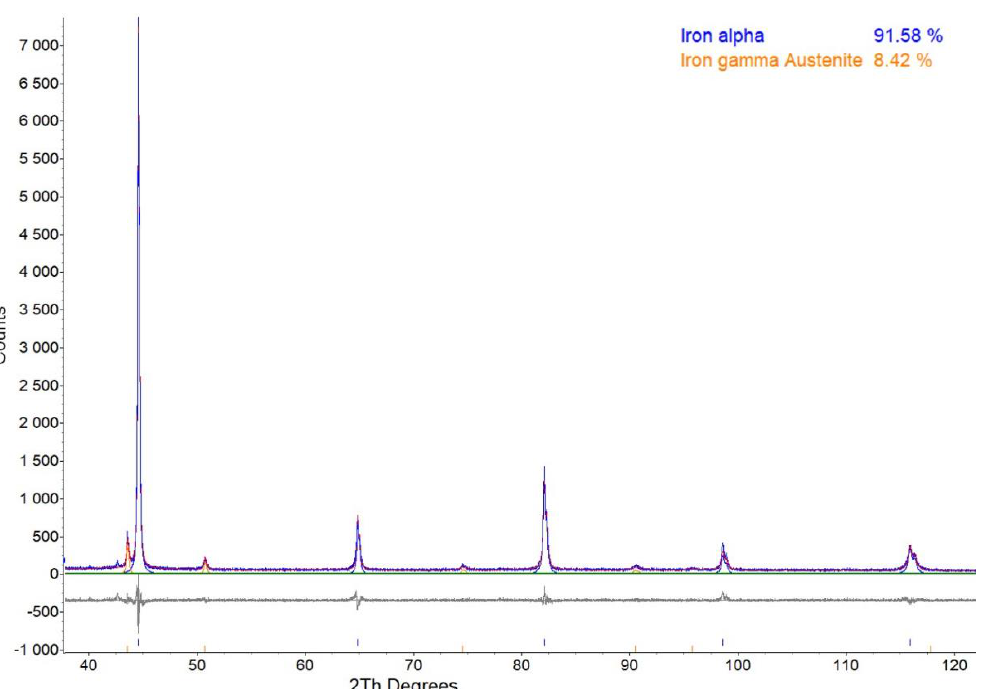
Figure 2. Measured full-spectrum, fitted interference function and difference curve of a powder mixture.